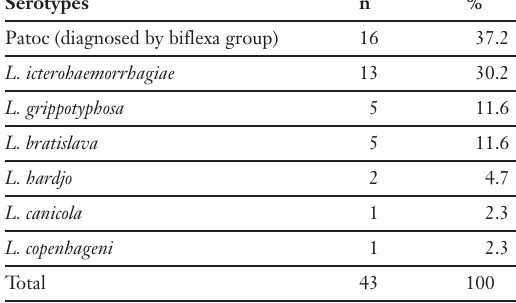
Table 3 43 MAT test